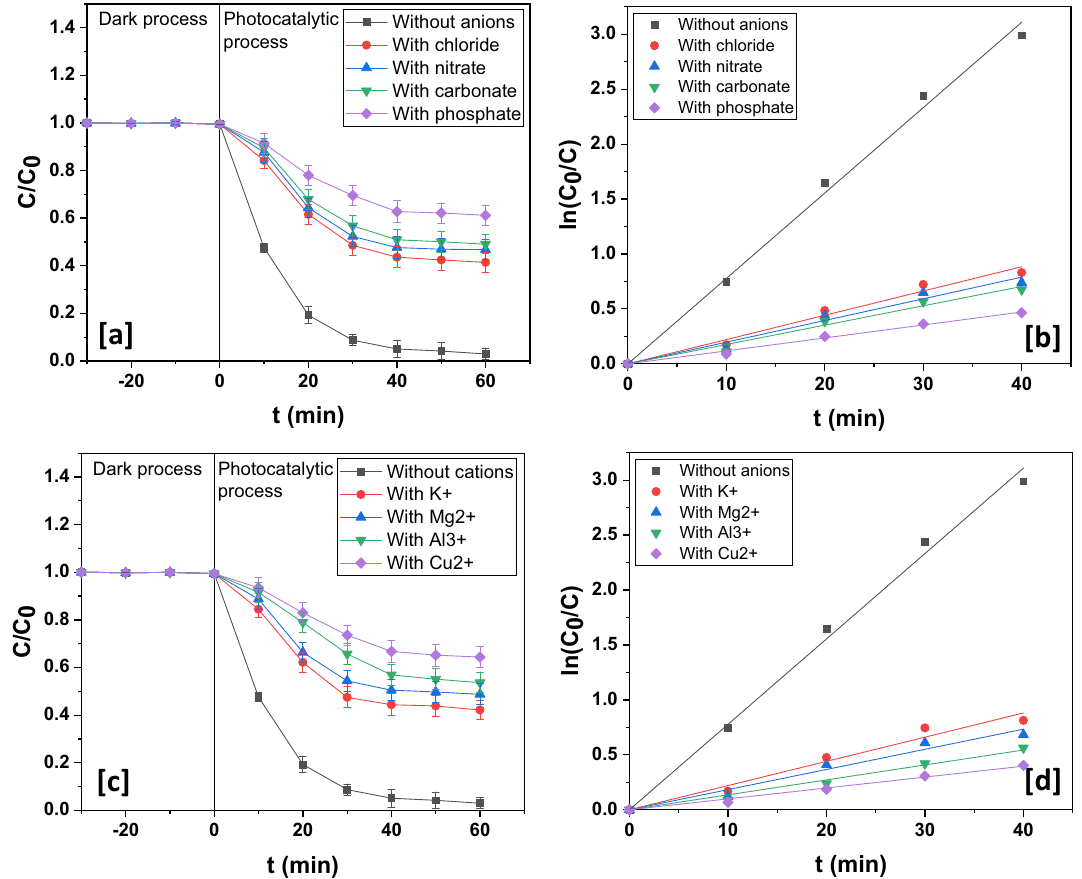
Figure 15. ( a ) Dynamics and ( b ) kinetics profile in presence of different anions. ( c ) Dynamics and ( d ) kinetics profile in presence of different